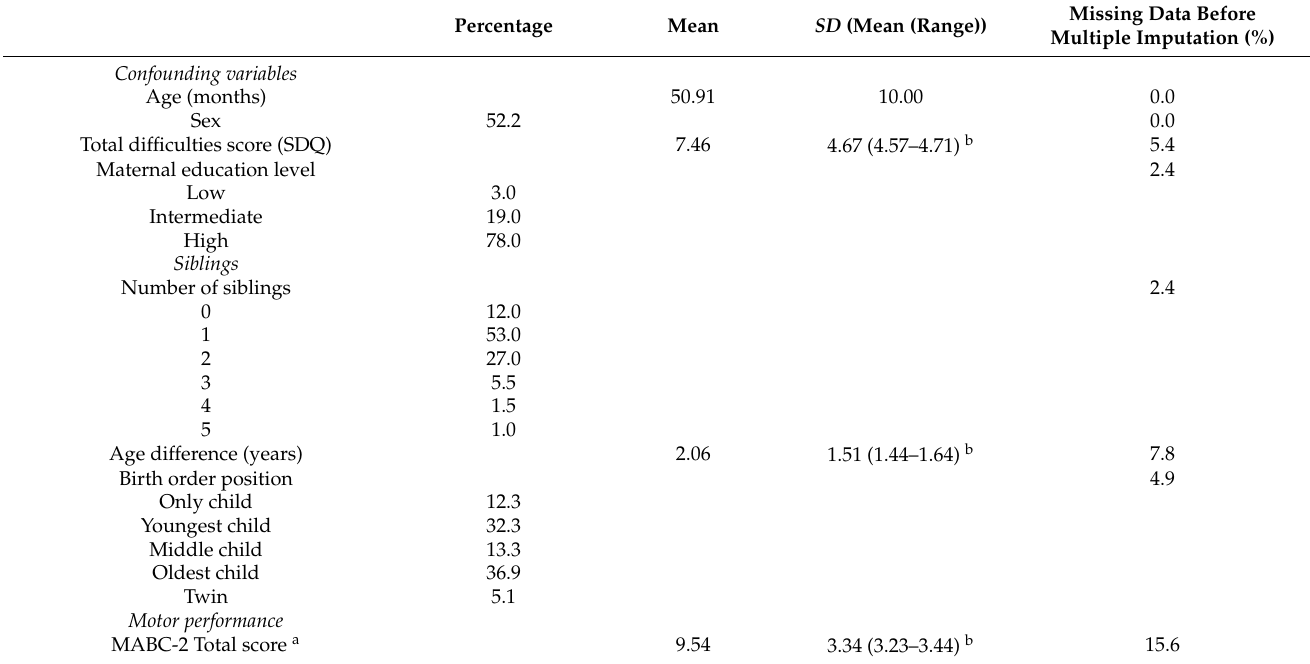
Table 1. Pooled means and standard deviations for the study variables and percentage of missing data before multiple